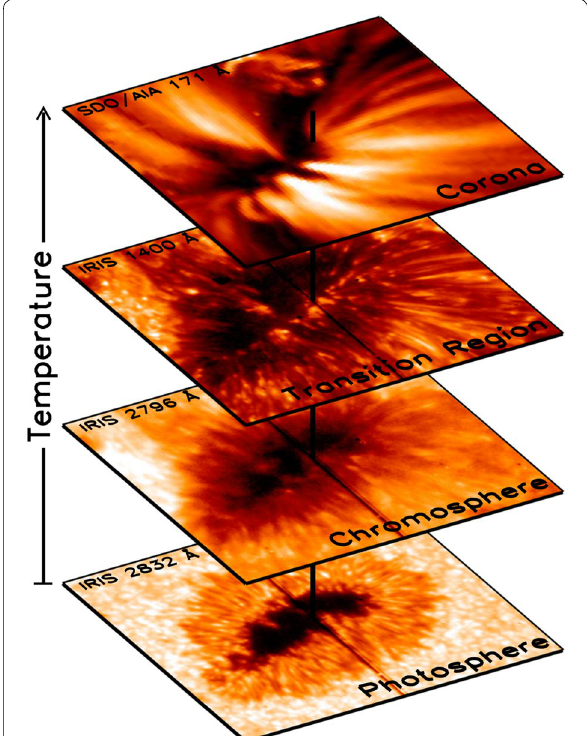
Fig. 1 Images of the photosphere (upper left, IRIS SJI 2832 Å), chro- mosphere (upper right, IRIS SJI 2796 Å), TR (lower left, IRIS SJI 1400 Å) and lower corona (lower right, SDO/AIA 171 Å) in a sunspot region. These images were taken on July 20, 2013. The field of view of each image has a size of 50 ″ 42 ×